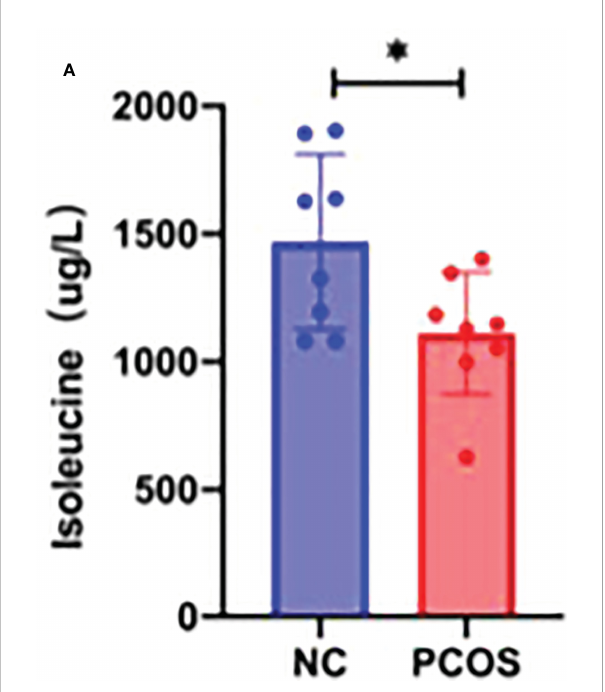
FIGURE 7 GC – MS/MS-targeted amino acid metabolism analysis. (A) Histogram showing the concentration of isoleucine in the NC group and PCOS group. *p <